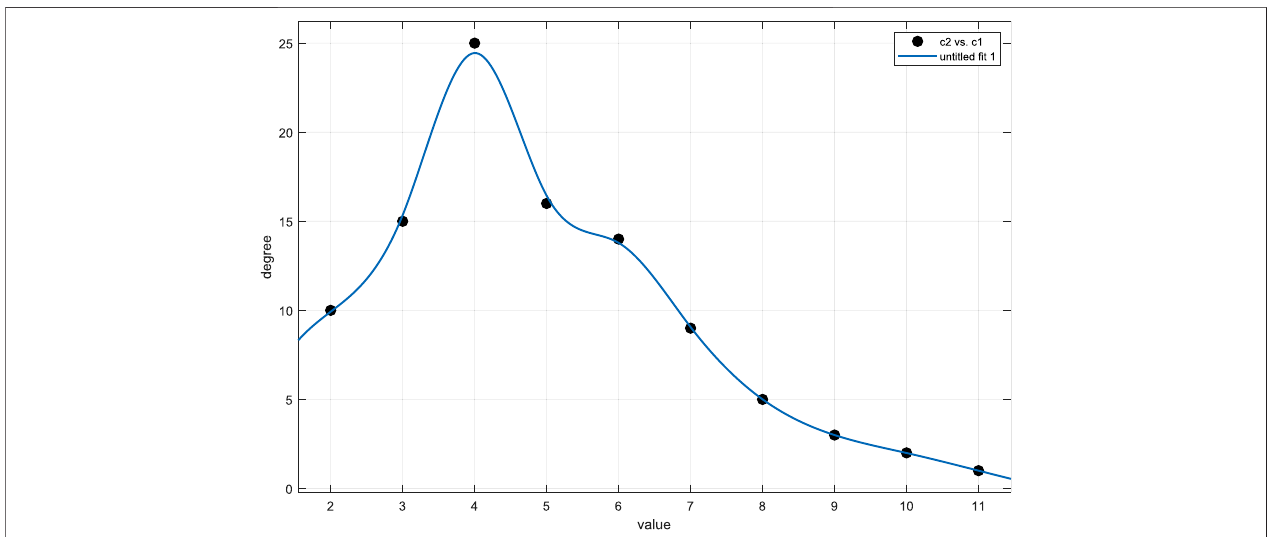
FIGURE 3 | Distribution of the cellular network.